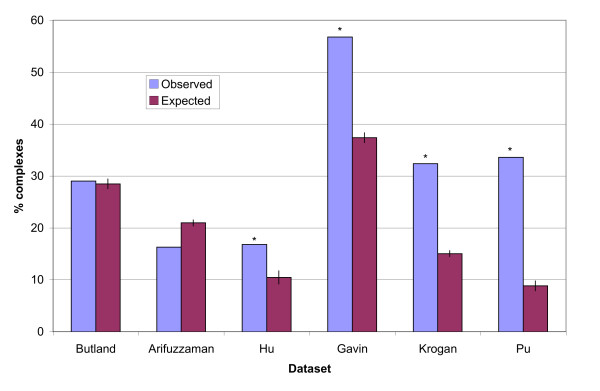
Percentage of complexes containing homologous pairs for alternative datasets. Asterisks show observed values which were significantly above random.